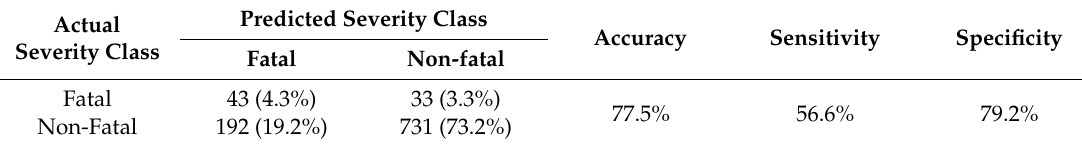
Table 3. Confusion matrix for model performance